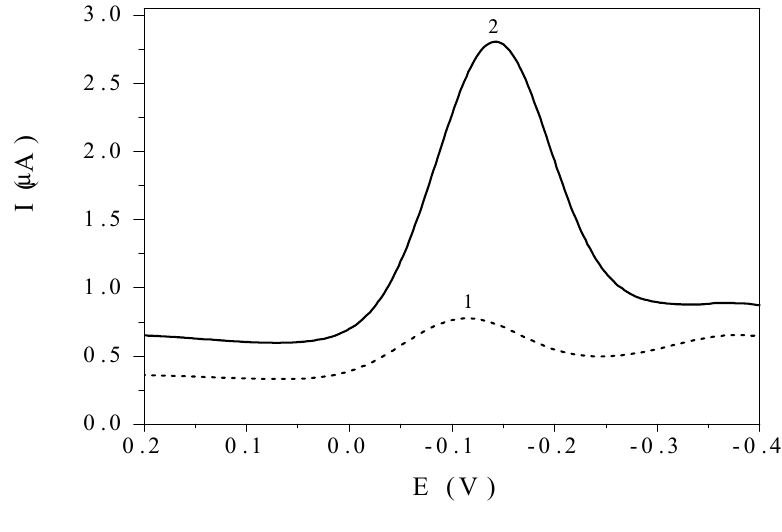
Figure 1. DPV curves of the [Co(phen) ] 3+ complex in its 5 × 10 -7 M solution obtained with 3 SPE (1) and DNA/SPE (2) after 120 s accumulation at an open circuit, 10 mM phosphate buffer pH 7.0, pulse amplitude 100 mV, scan rate 25